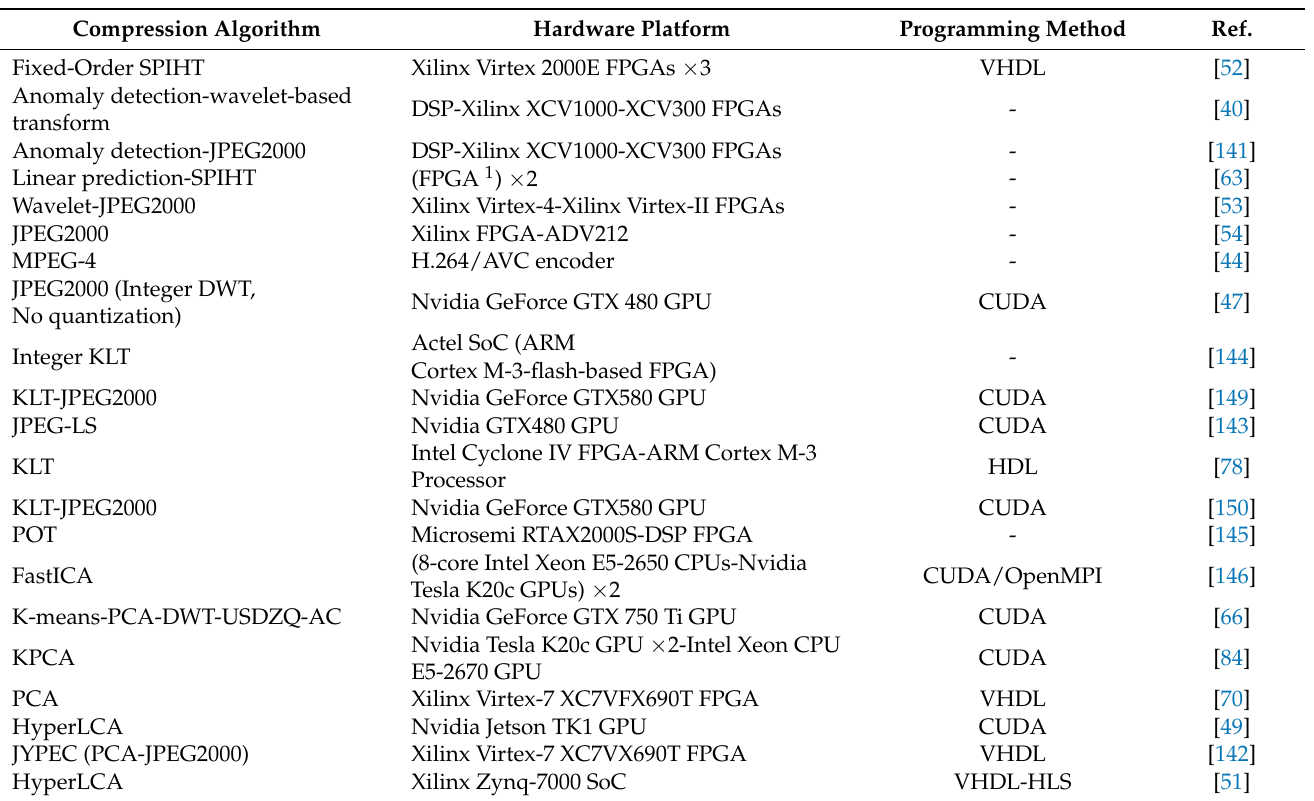
Table 4. List of studies on transform-based compression systems of hyperspectral images and their hardware platforms.